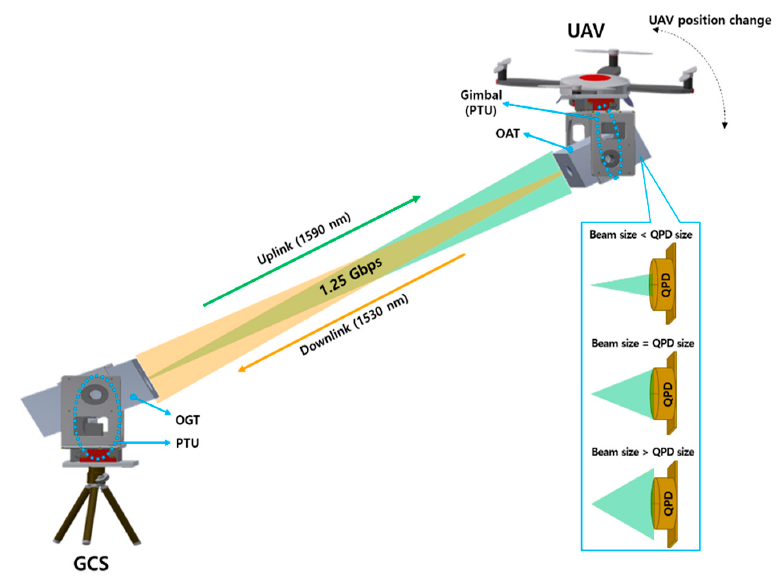
Figure 1. System concept of free space optical (FSO) communication between ground control station (GCS) and unmanned aerial vehicle (UAV).